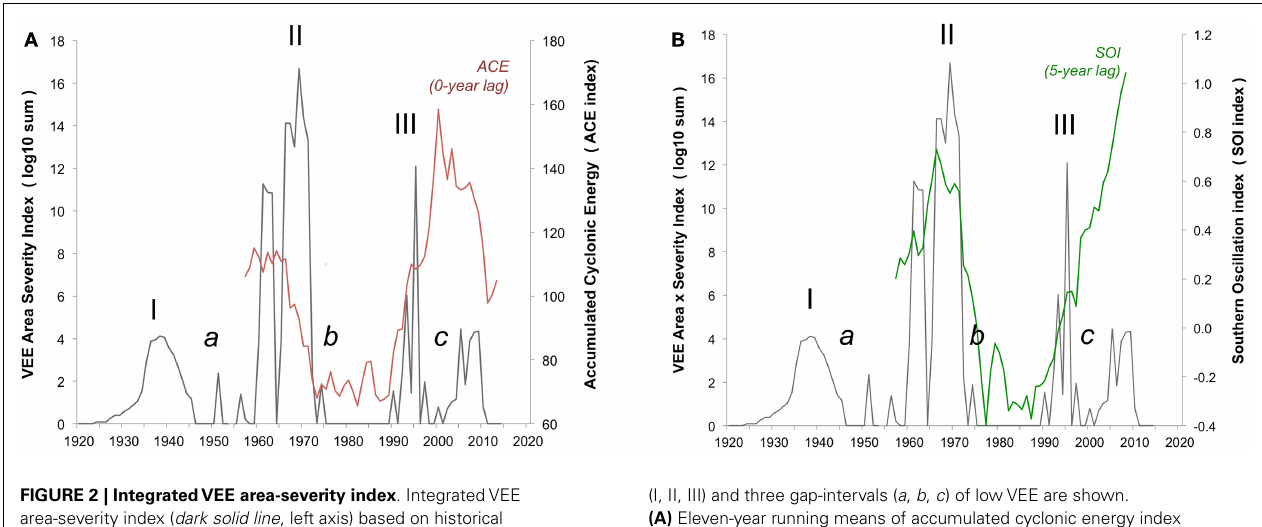
FIGURE 2 | IntegratedVEE area-severity index . IntegratedVEE area-severity index ( dark solid line , left axis) based on historical reconstruction of areal extent and severity in equine and human populations over the 1920 through 2013 period.Three majorVEE outbreaks